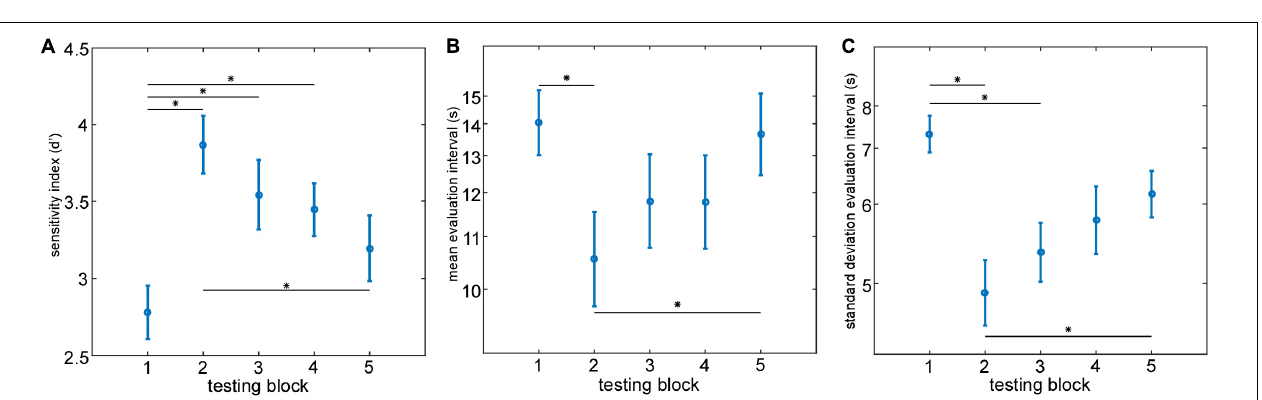
FIGURE 5 | Group mean attended speaker decoding profile with ± 1 SEM (shaded area) plotted as a function of time derived from ASR artifact attenuated EEG data (red) and ASR uncorrected EEG data (black).